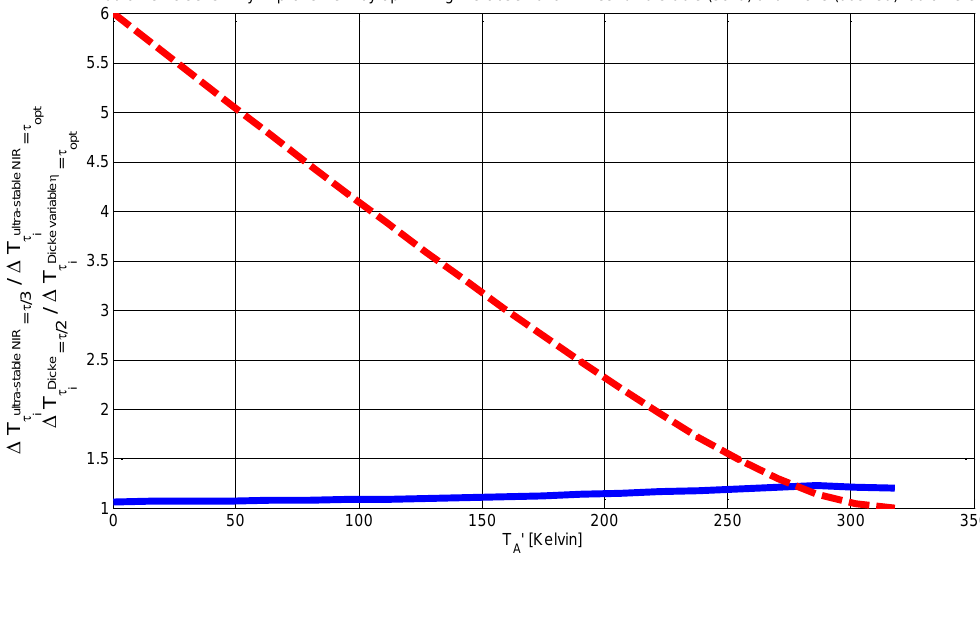
Figure 4. Radiometric resolution improvement for the ultra-stable radiometer. For the